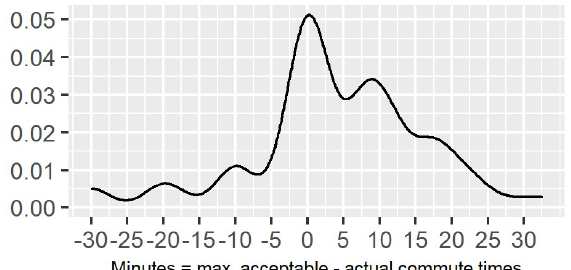
Figure 4. The density distribution of the time dif- ference between maximum acceptable commute times and actual commute times (n = 182).